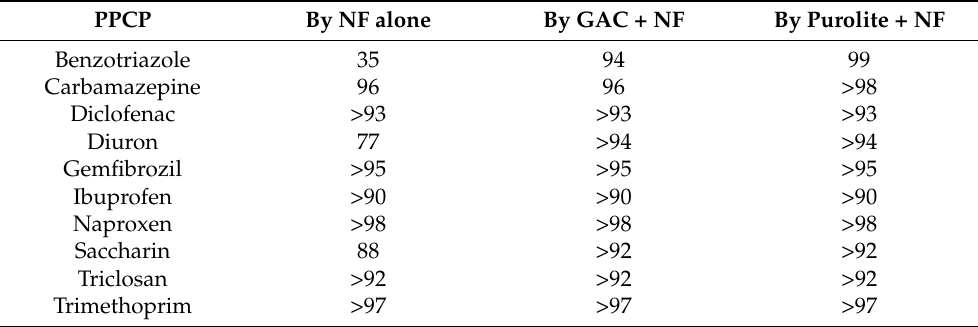
Table 1. Removal of 10 PPCPs from MF wastewater by NF and NF with adsorption pre-treatment